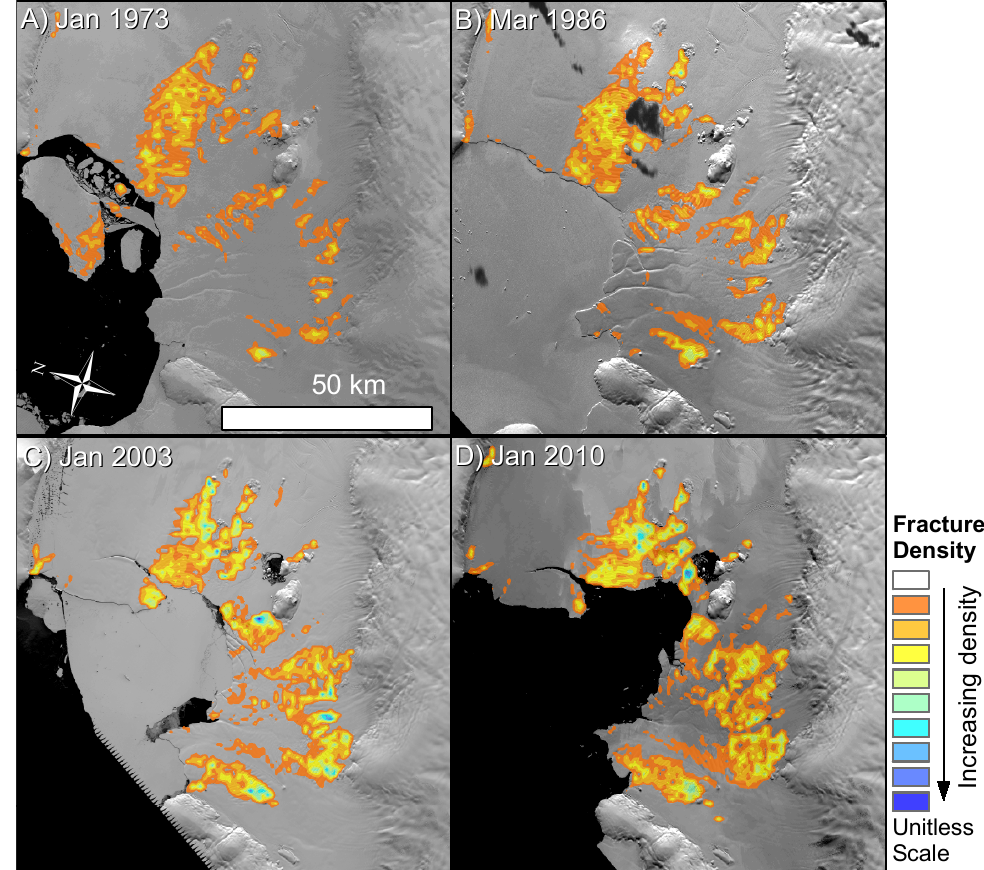
Fig. 9. Fracture trace and rift distribution and density (see Fig. 5 for structural maps) over four time periods ( (A) 1973, (B) 1986, (C) 2003 and (D) 2010). Increasing density is noted both north and west of the Eklund Islands in areas where widespread thinning has been shown. Increased rifting between the Eklund Islands and De Atley Island is also linked to increasing ice-shelf flow speeds recorded between ca. 1989 and ca. 2010 (Fig.